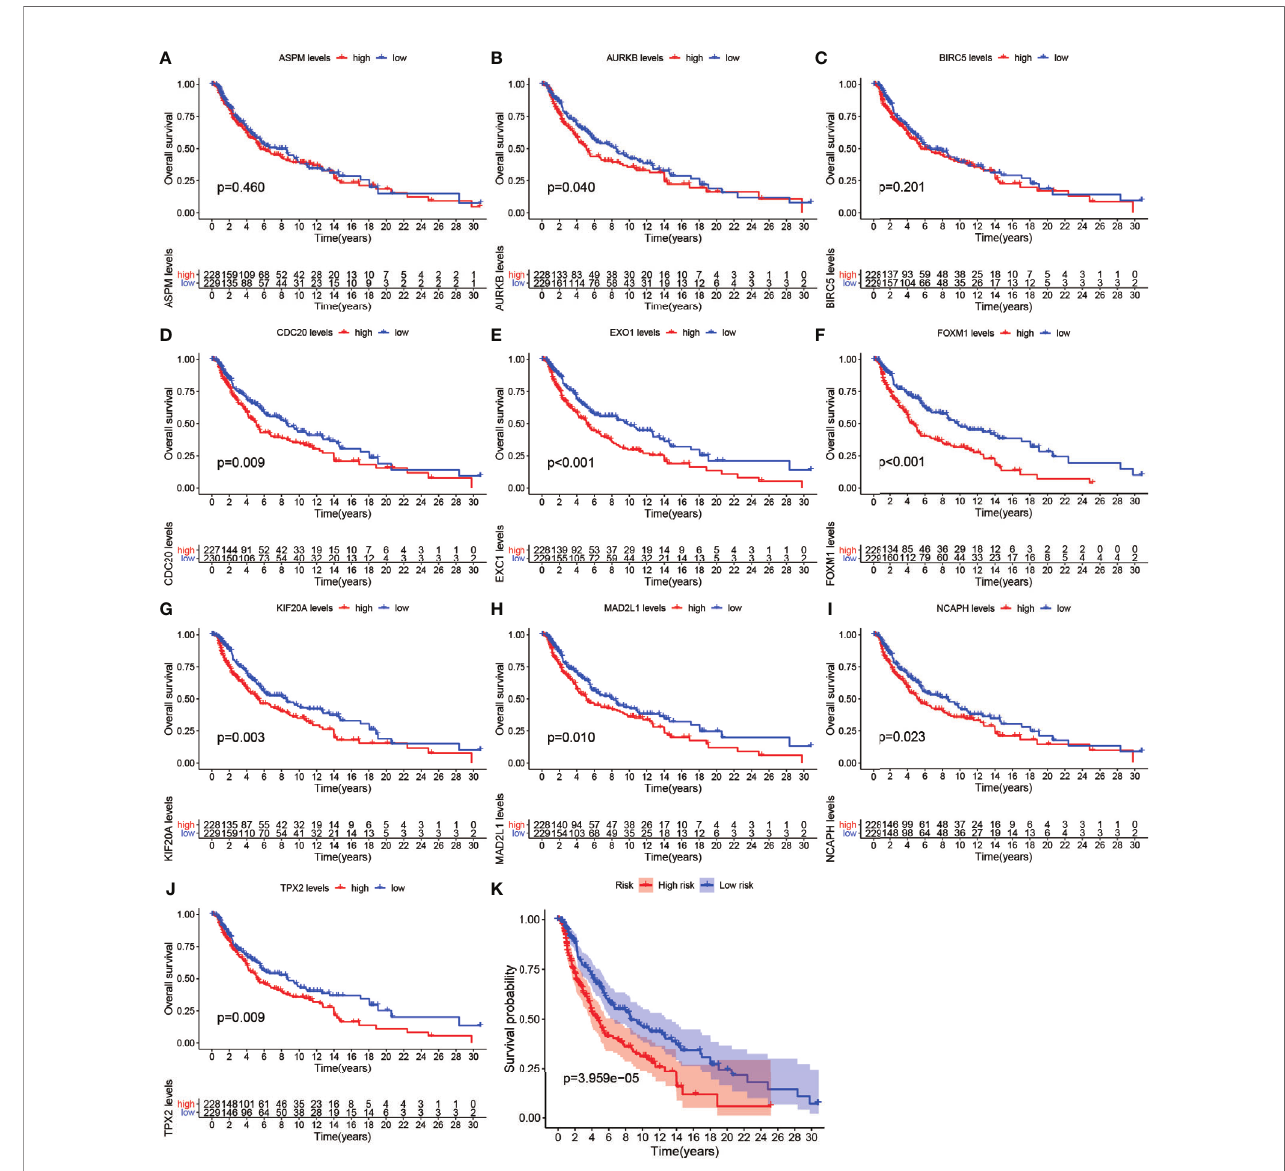
FIGURE 8 | Survival analysis. (A – J) shows the survival curves of the fi rst 10 Hub genes. (K) shows the survival curves for high-risk and low-risk based on the prognostic